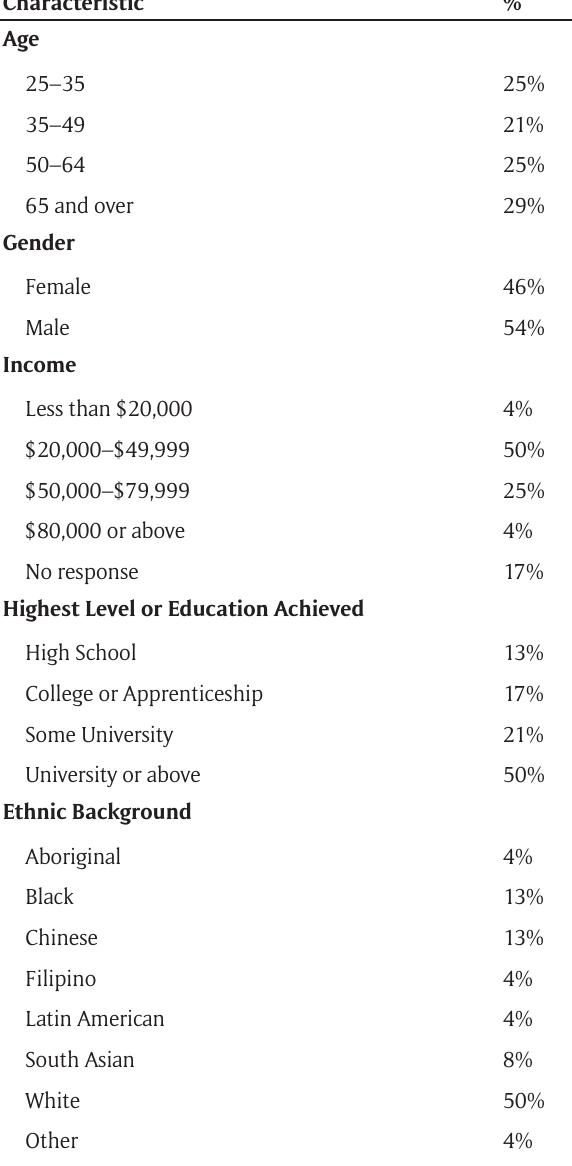
Table 1: Participant